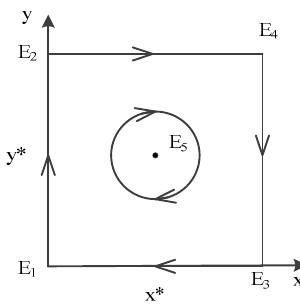
Figure 8. Diagram on dynamic evolution of equilibrium points in E 5 ( x ∗ ,y ∗